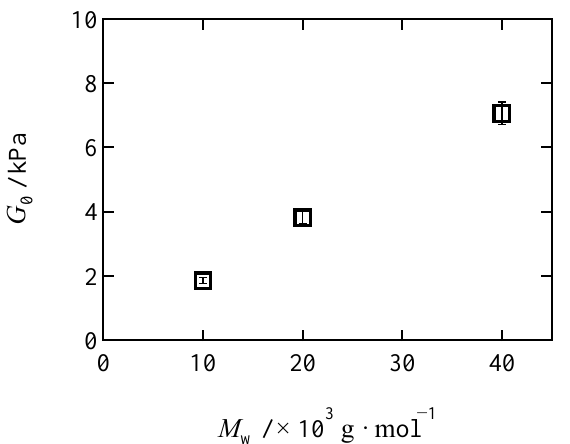
Figure 2. The molecular weight ( M w ) dependence of the shear modulus ( G 0 ) for the Tetra-PAA-PEG gels.